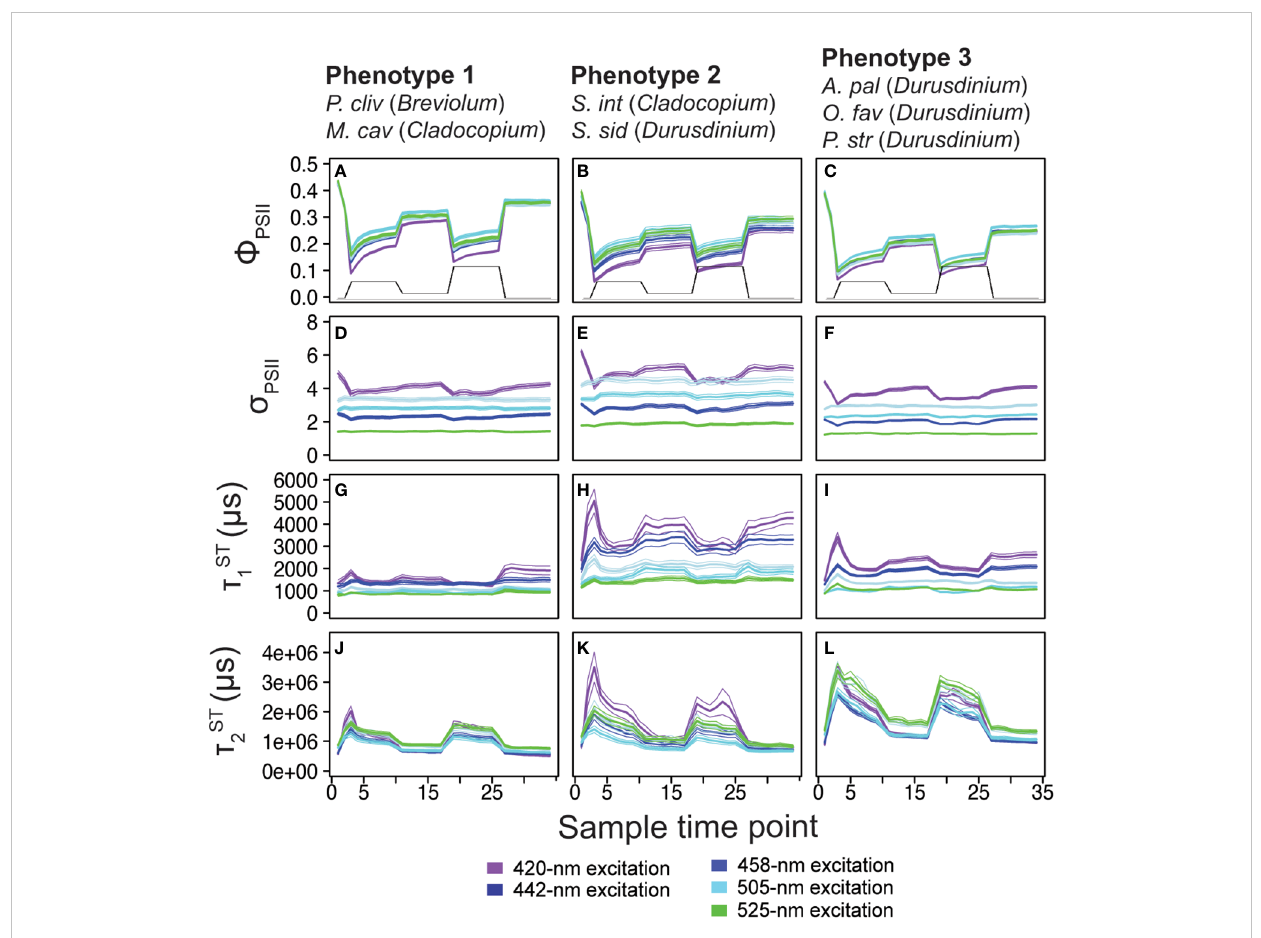
FIGURE 3 Phenotype pro fi les. Average (± standard error) traces for photo-physiological metrics identi fi ed within Figure 2; quantum yield of PSII ( F PSII ; A-C) absorption cross-section of PSII ( s PSII ; D-F) , and t 1ST ( t ST 1 ; G-I) and t 2ST ( t ST 2 ; J-L) reoxidation kinetics are displayed for phenotype 1(left column), phenotype 2 (middle column), and phenotype 3 (right column). Spectrally dependent responses for each of the fi ve excitation wavelengths are re fl ected in each panel (thick bar = average, thin bars = standard error). For reference, the light protocol pro fi le is inlaid within panels (A-C)